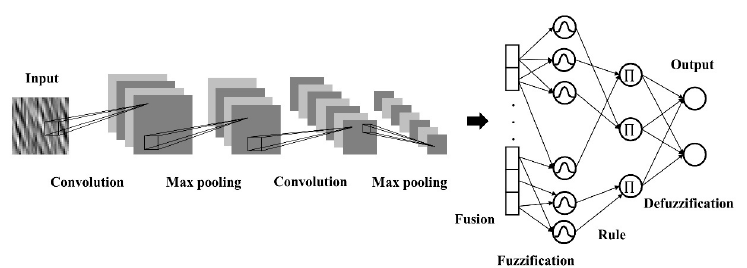
Figure 2. Architecture of